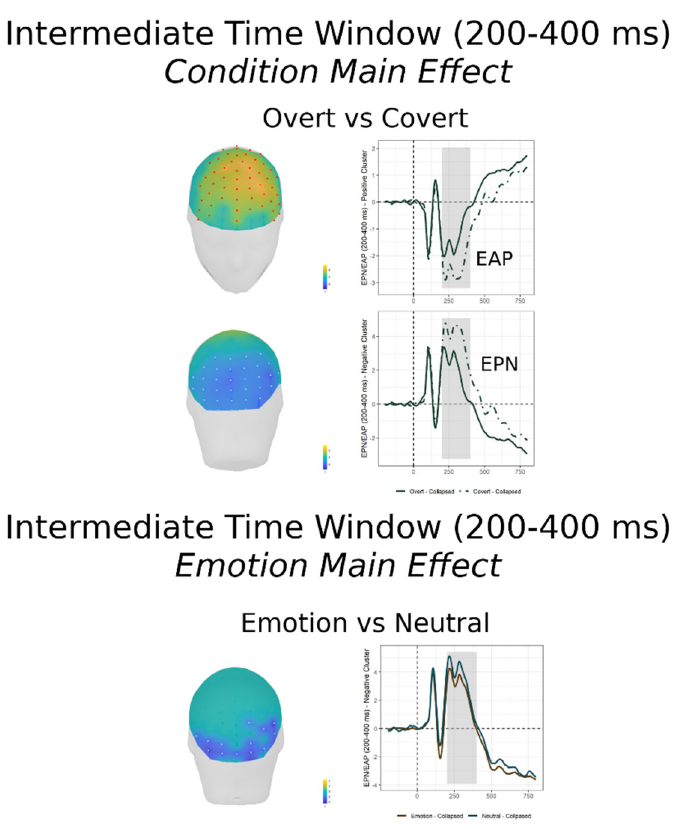
Figure 3. Intermediate time window (200–400 ms): On the right of each panel, grand-average waveforms of the electrodes included in the significant positive and negative clusters; on the left of each panel, the scalp topography of the significant clusters (the sensors included are highlighted in red for the positive clusters and in white for the negative clusters). Left panel: Overt vs. Covert, collapsed across emotions; right panel: Emotion vs. Neutral, collapsed across conditions.